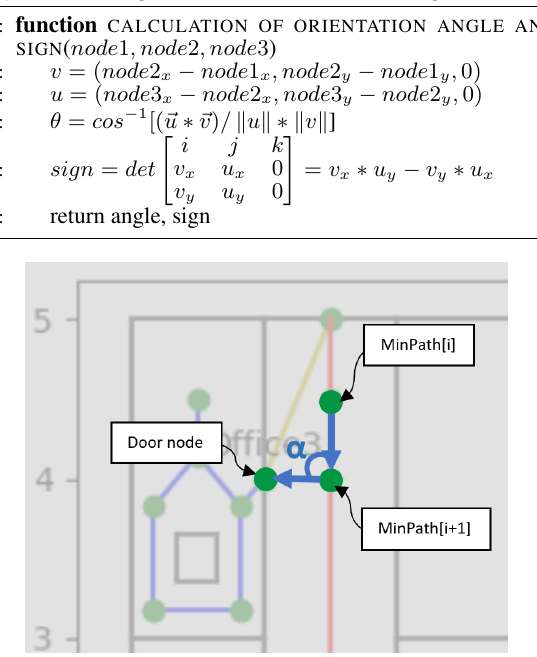
Algorithm 2 Algorithm for orientation and sign